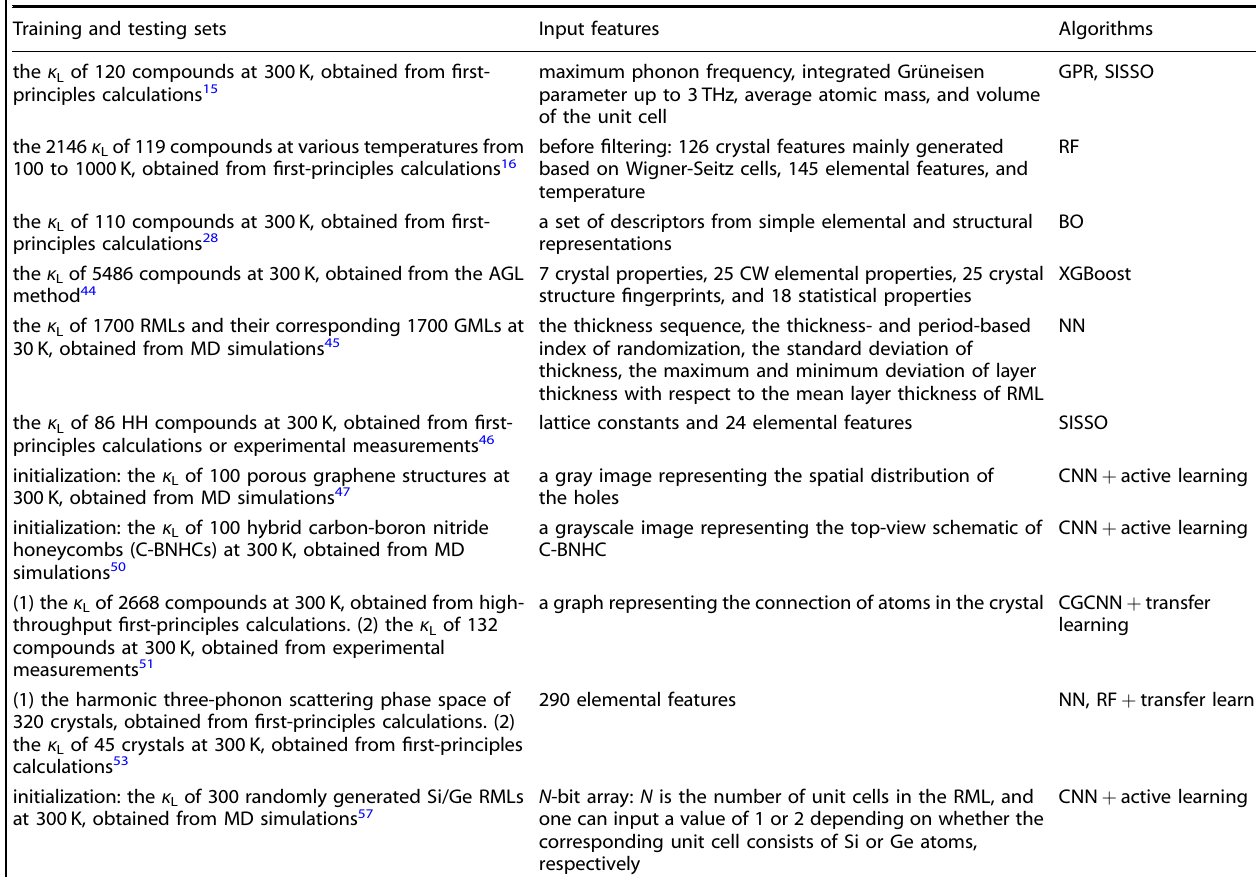
Table 1. Summary of representative machine learning works on the direct prediction of lattice thermal conductivities in recent 5 years. Training and testing